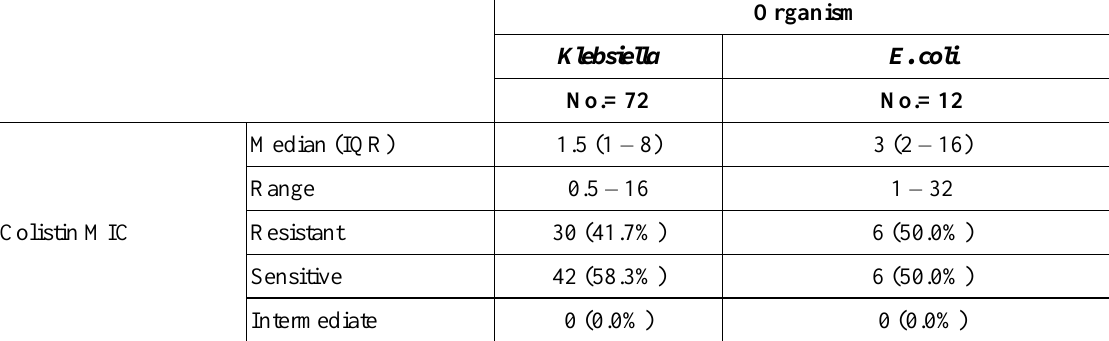
Table 5. Colistin susceptibility among MDR K. pneumoniae and E.